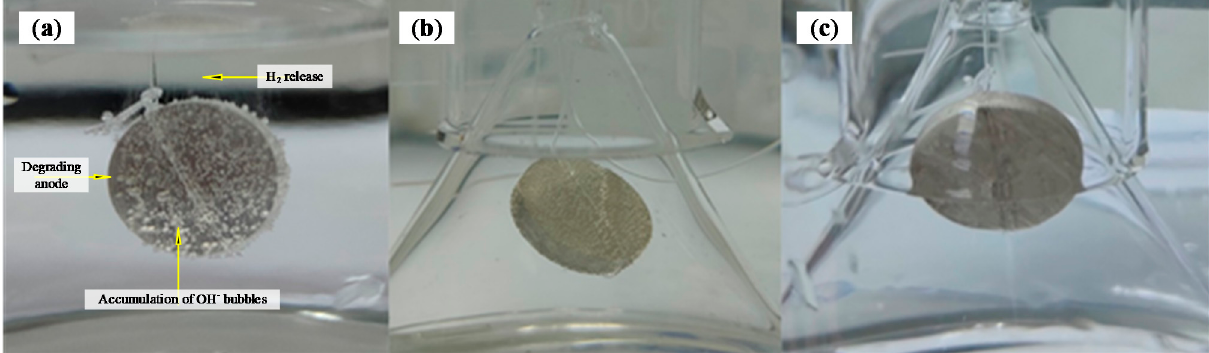
Figure 6. Photograph of Mg-1.0Ca-0.5Sr alloy immersed in r-SBF with increasing immersion time. ( a ) Rapid anodic dissolution during early immersion results in higher OH − accumulation over the cathodic area during the earliest 1 h immersion; ( b ) slower anodic dissolution and reduced OH − accumulation were observed at 48 h, indicating active precipitation of corrosion products on the alloy surface; and ( c ) unnoticeable OH − accumulation at the increased immersion time (336 h), suggesting a uniform coverage of passivating deposits across the alloy’s surface at 336